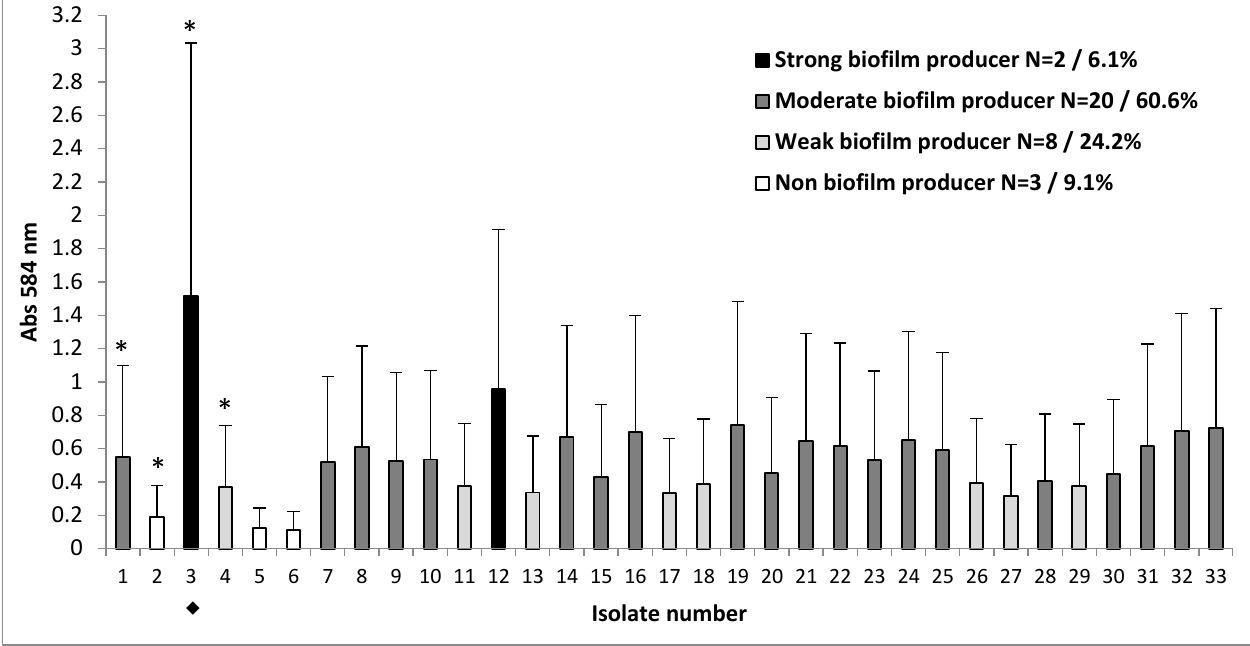
Figure 1. Biofilm-forming capacity of S. aureus clinical strains. The strains of S. aureus were assessed for their ability to form a biofilm and accordingly classified as strong, moderate, weak, and non-producers. Results are expressed as the mean value ± standard deviations of the mean of at least 5 independent experiments performed in triplicate. To classify the strains into groups that showed significant differences, statistical analysis was performed using Student’s t -test (* p < 0.05). The isolate number 3 that formed high levels of biofilm is indicated ( (cid:7)